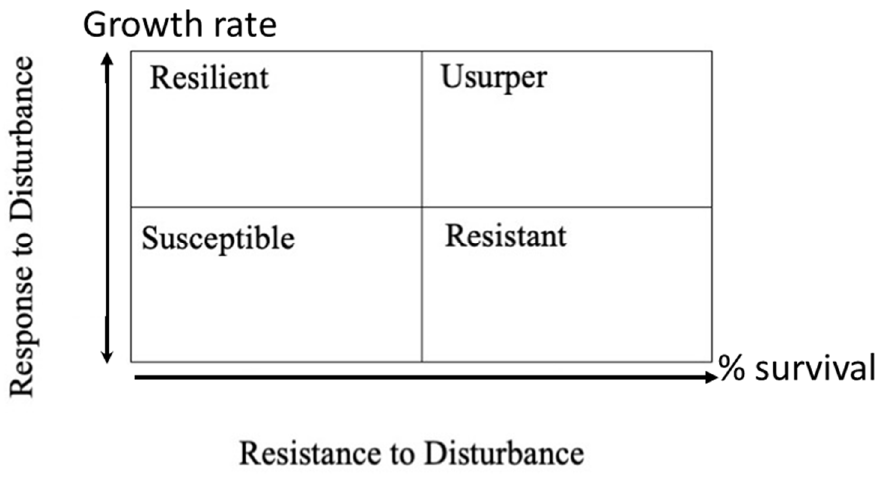
Figure 1. Diagram of categorizations of individual species roles within a forest type after hurricane disturbance (adapted from [18]).